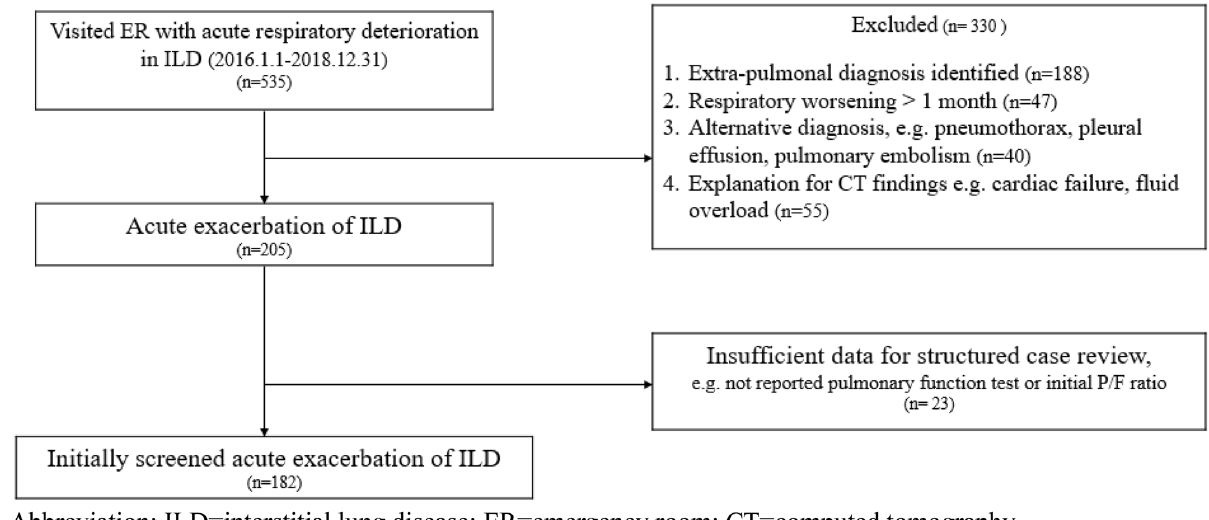
Figure 1. Patient recruitment flowchart. ILD interstitial lung disease, ER emergency room, CT computed